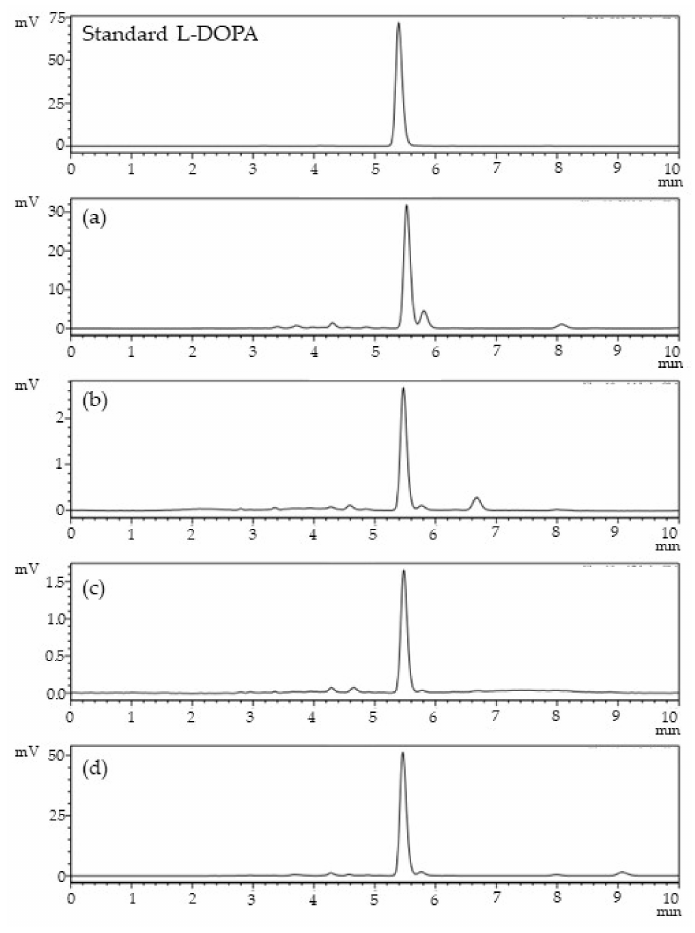
Figure 2. HPLC chromatograms of L-DOPA extracted from ( a ) MGG, ( b ) MIT, ( c ) MMM, and ( d ) MPR.